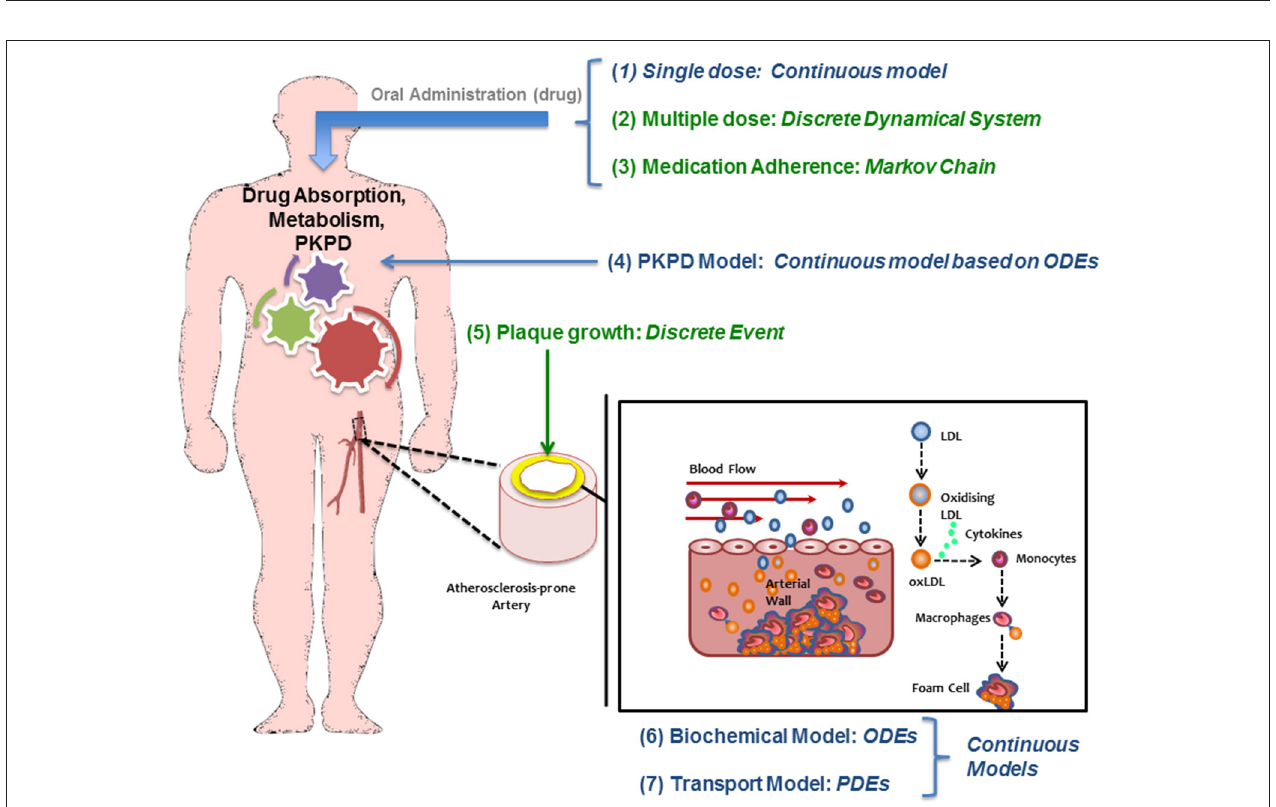
FIGURE 2 | Diagram of the multiscale modeling approach showing how different mathematical approaches are used/needed to study atherosclerosis and its treatment.